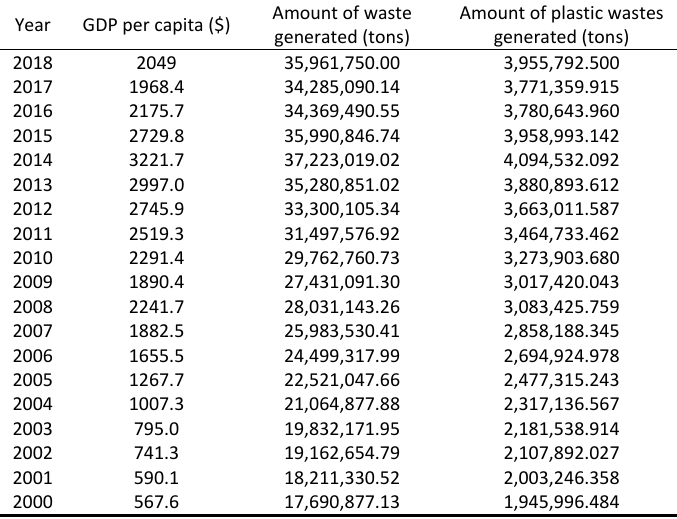
Table 1: Estimates of waste generated in Nigeria between 2000 and 2018